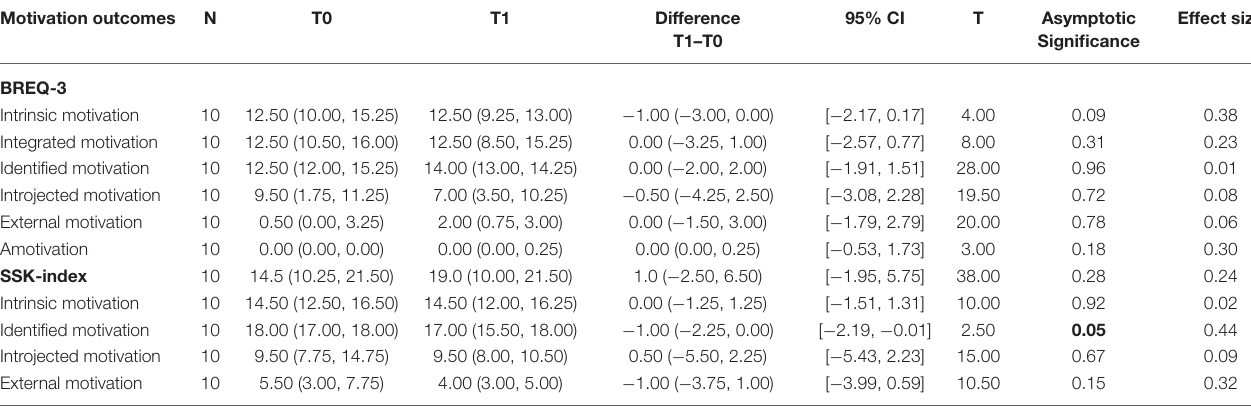
TABLE 6 | Results secondary motivational